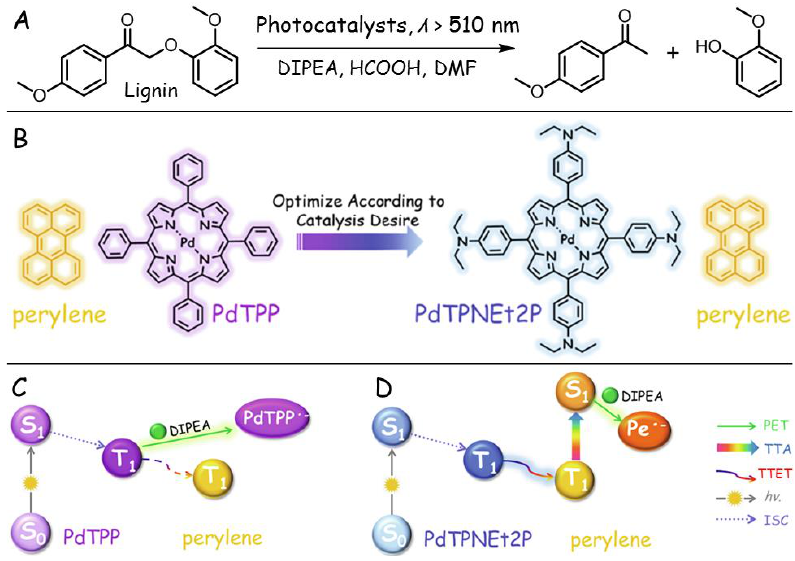
Figure 9. ( A ) Chemical reaction of the degradation of oxidized lignin model triggered by TTA-UC. ( B ) Molecular structures of the selected TTA-UC pairs: PdTPP/perylene pair